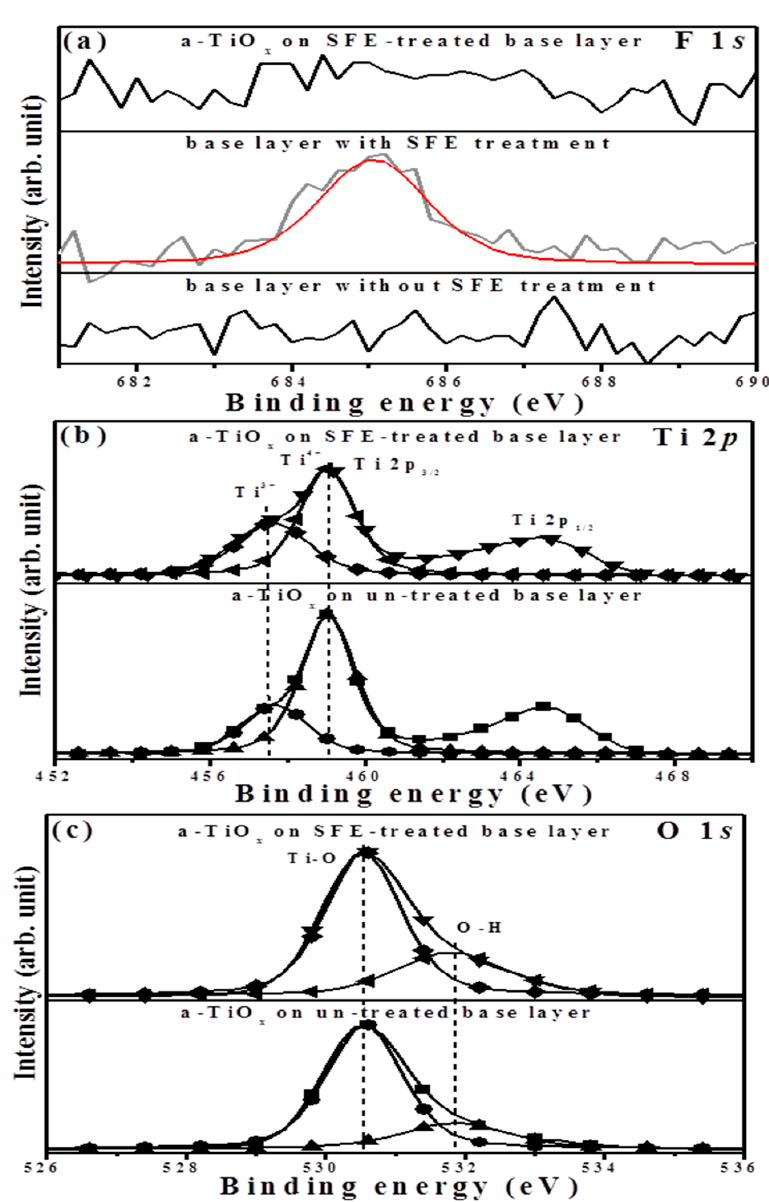
Figure 8. Binding energies related to the ( a ) F 1 s core of the untreated and SFE-treated base layers as well as that of the a-TiO x deposited onto the SFE-treated based layer; ( b ) Ti 2 p ; and ( c ) O 1 s core levels of the a-TiO x film deposited onto the untreated and SFE-treated base layers.